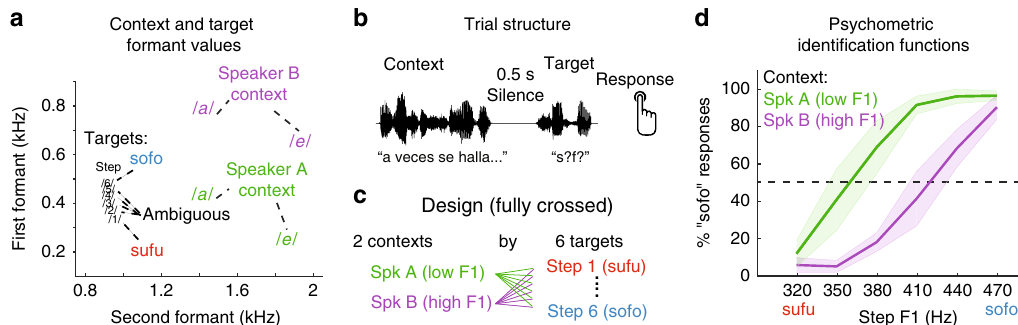
Fig. 1 Listeners perceive speech sounds relative to their acoustic context. a Target sounds were synthesized to create a six-step continuum ranging from sufu (step 1; low- fi rst formant [F1]) to sofo (step 6; high F1). Context sentences were synthesized to sound like two different speakers: a speaker with a long vocal tract (low-F1 range: Speaker A), and a speaker with a short vocal tract (high-F1 range; Speaker B). Context sentences contained only the vowels / e / and / a /, but not the target vowels / u / and / o /. b Context sentences preceded the target on each trial (separated by 0.5s of silence), after which participants responded with a button press to indicate whether they heard “ sufu ” or “ sofo ” . c All targets were presented after both speaker contexts. d Listeners more often gave “ sofo ” responses to target sounds if the preceding context was spoken by Speaker A (low F1) than Speaker B (high F1). Error bars